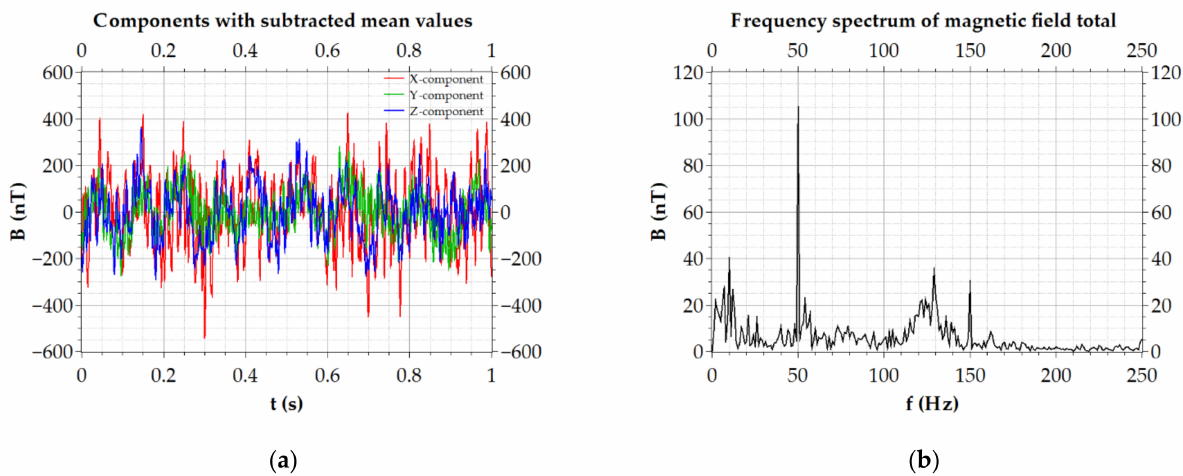
Figure 12. Example of 1 s signal recording: ( a ) time development of the magnetic field components; ( b ) spectrum of the corresponding magnetic field